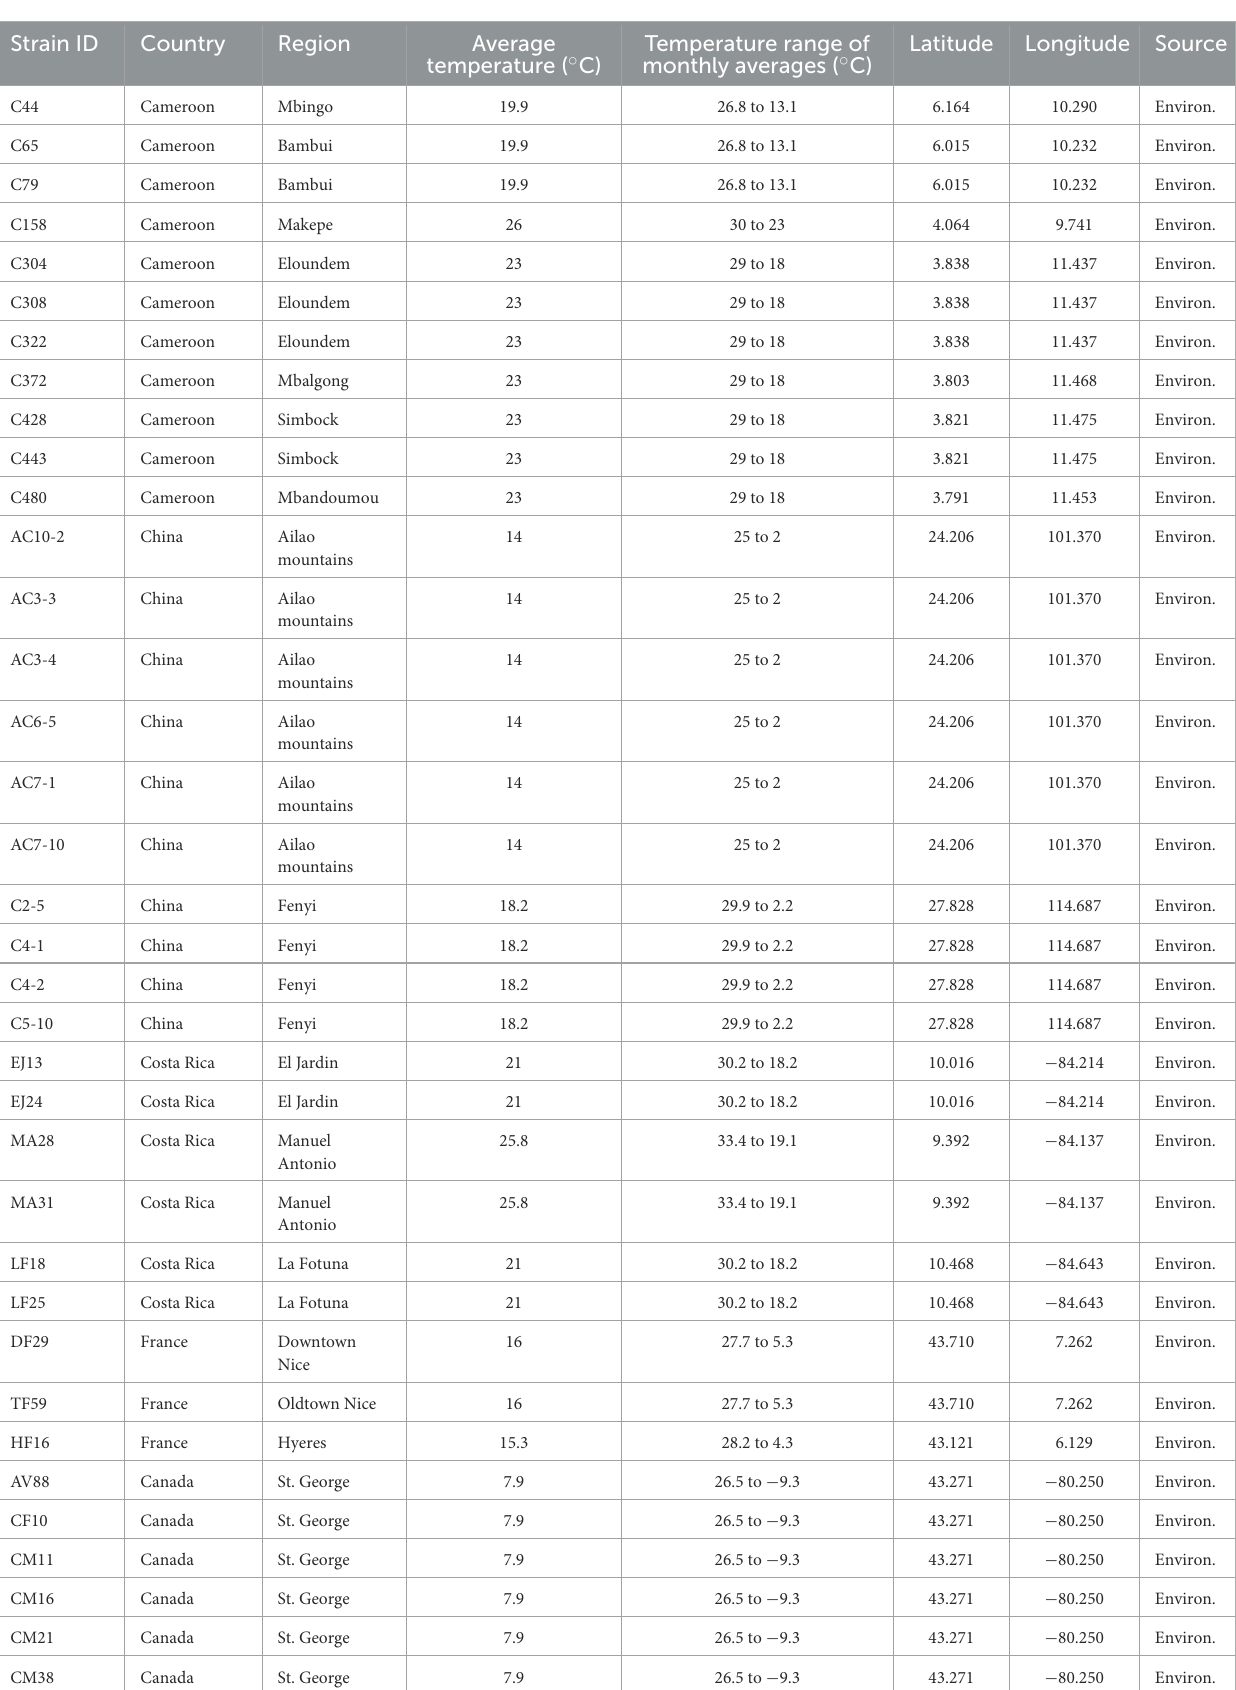
TABLE 1 Metadata about the 89 A. fumigatus strains used in this study. Strain